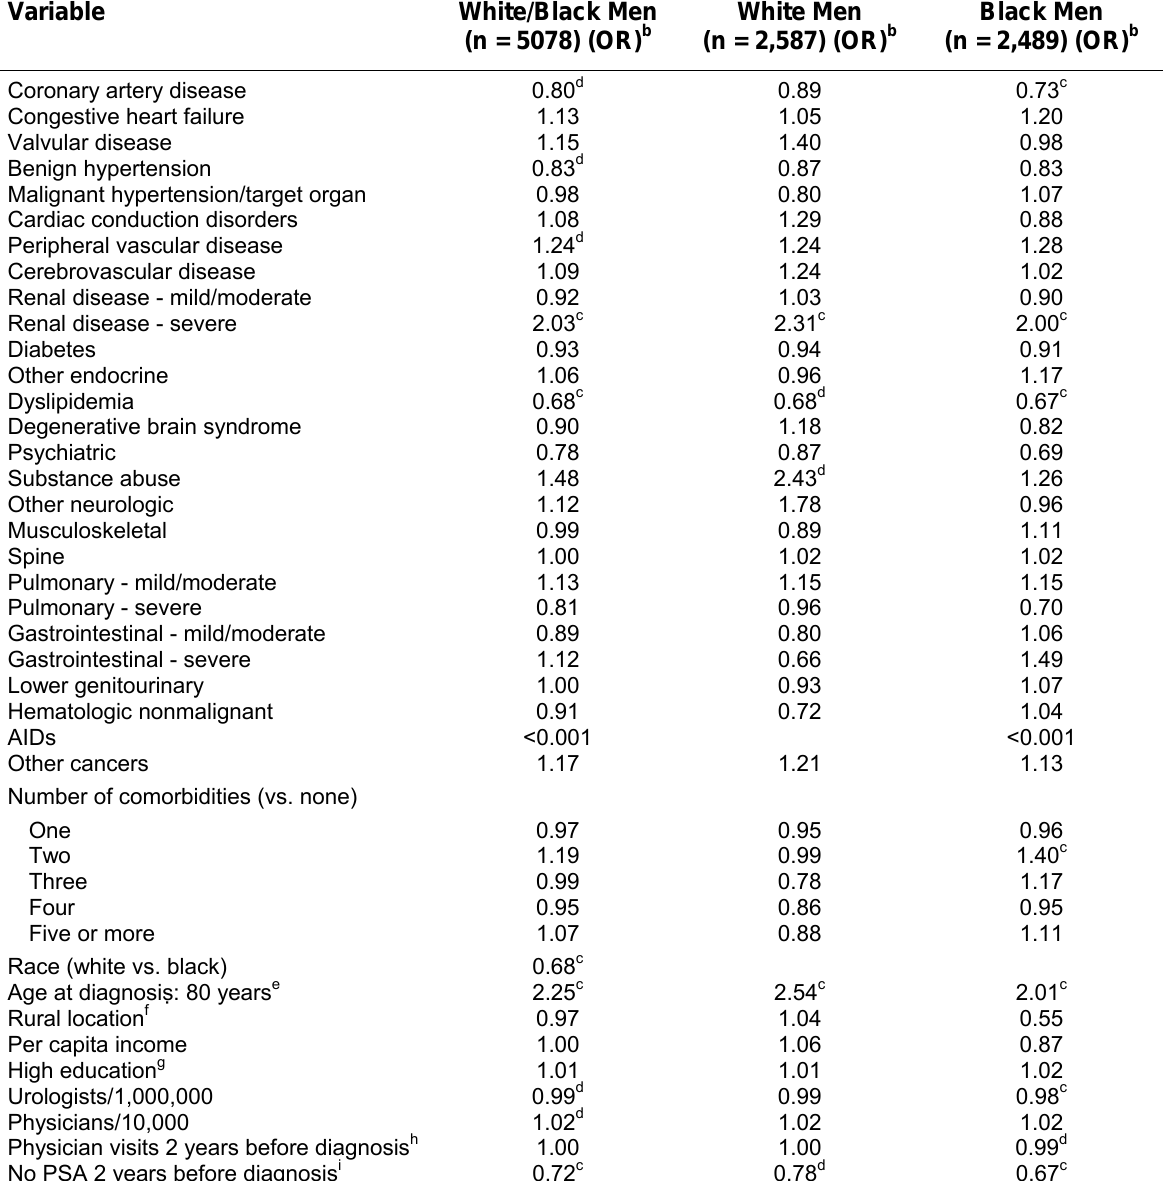
Multivariate Associations of Comorbidities with Late-Stage Prostate Cancer